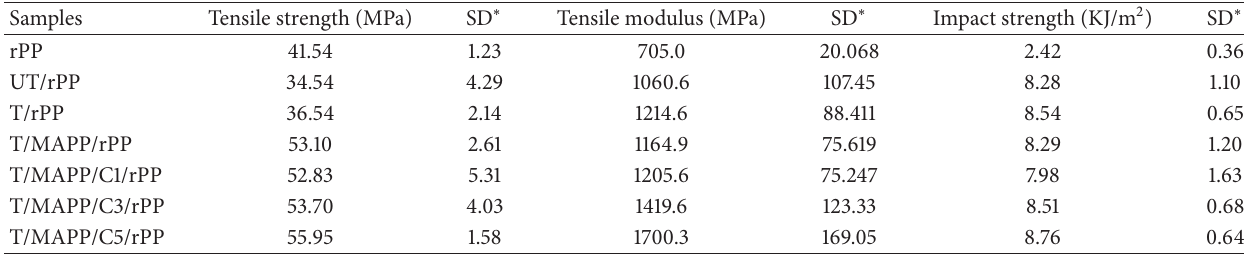
Table 4: Mechanical properties of rPP composites.